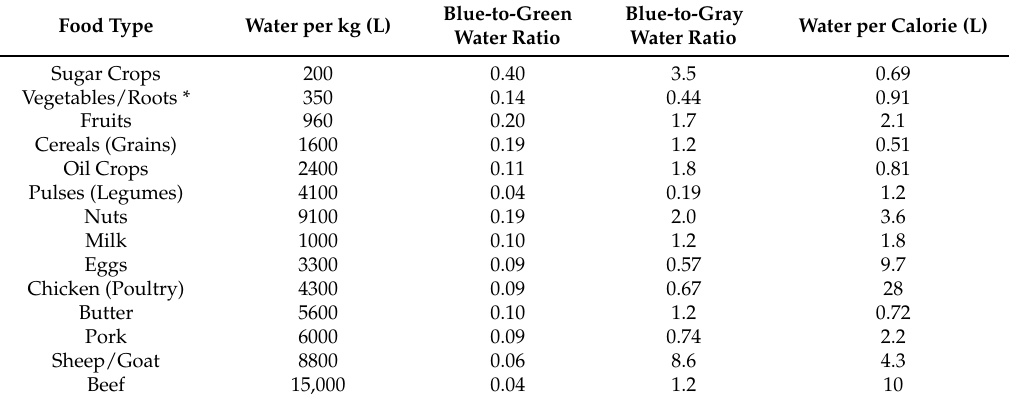
Table 1. Global averages for the volume of water required to produce a kilogram of food, the ratios of blue-to-green and blue-to-gray water for food production, and the volume of water required per Calorie (kilocalorie) of food consumed. Based on data presented by A.Y. Hoekstra [13]. Food Type Water per kg